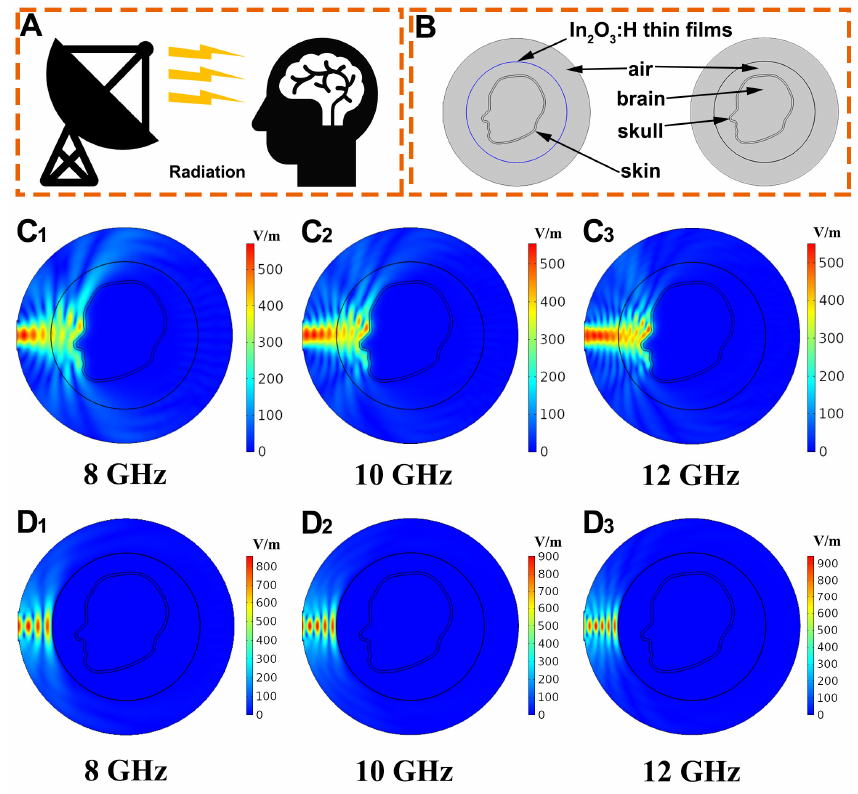
Figure 14. Simulation of the brain exposed to electromagnetic radiation from a radar antenna. ( A ) Schematic diagram of the model; ( B ) simplified radiation model. directly exposed brain and In 2 O 3 :H thin films protected brain; ( C 1 – C 3 ) unprotected electric field distribution map; ( D 1 – D 3 ) electric field distribution map in In 2 O 3 :H thin-films-protected brain.